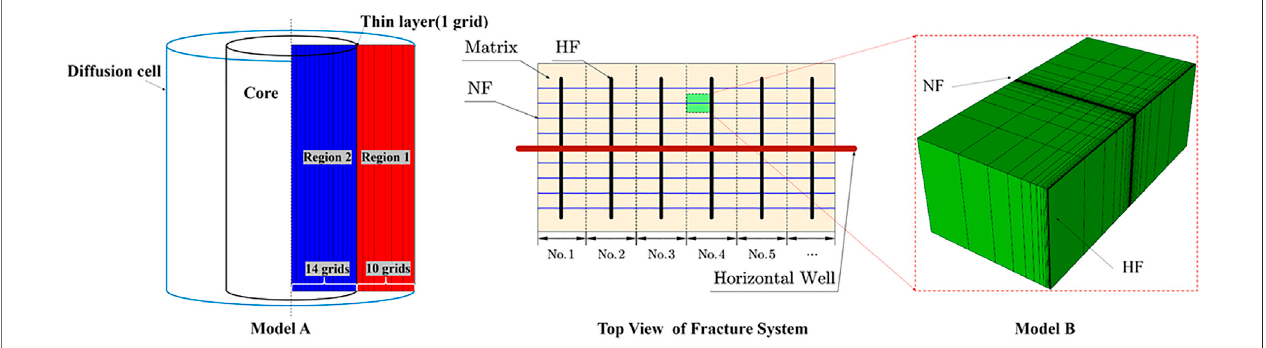
FIGURE 2 | Grid settings of model (A) and model (B)